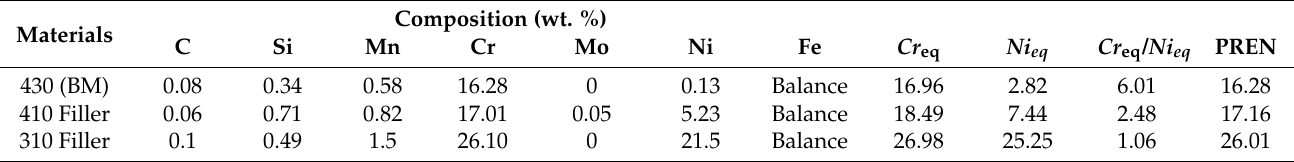
Table 1. Chemical composition of various materials.